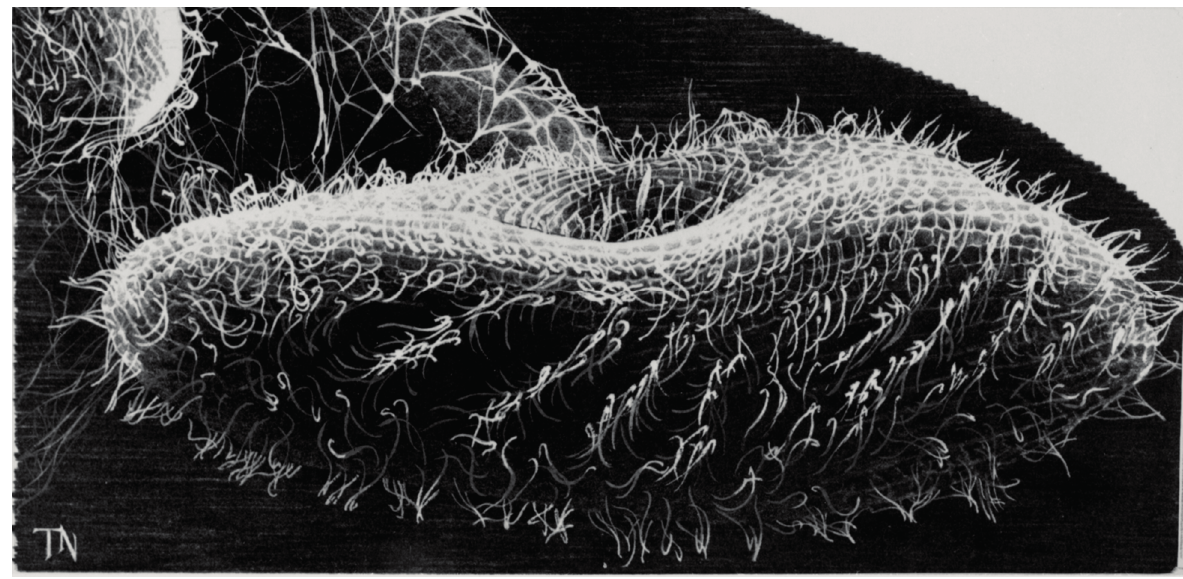
Figure 1. Paramecium tetraurelia showing the waves of cilia beating toward the posterior of the cell. From Grass Calendar,